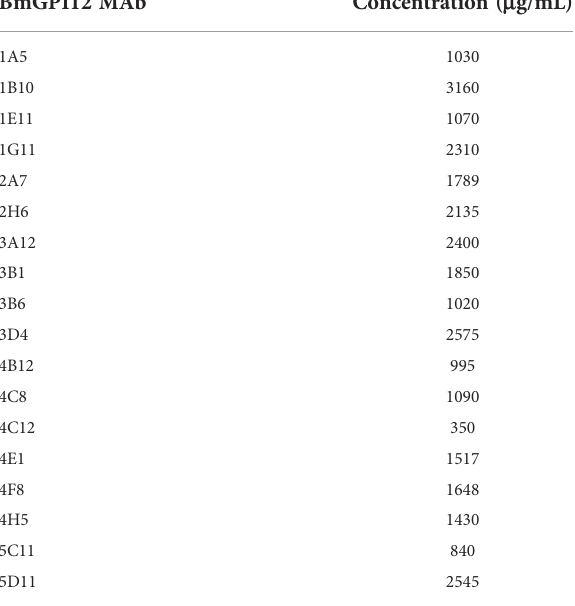
TABLE 1 List of BmGPI12 mouse monoclonal antibodies and their